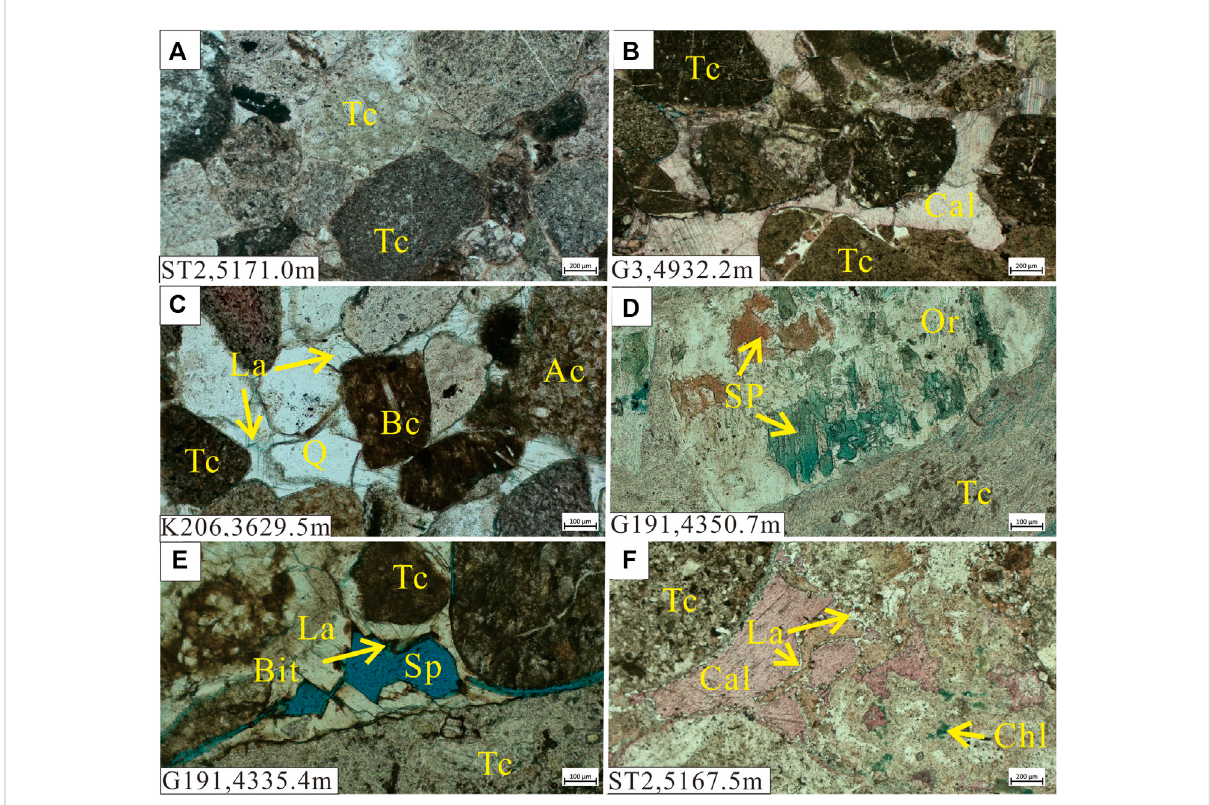
FIGURE 2 Photomicrographs of the Upper Wuerhe Formation. (A) Grayish white sandstone from a dry layer under plane-polarized light (PPL). (B) Water- bearing brown sandy conglomerate under PPL. (C) Water-bearing gray sandy conglomerate under PPL. (D) Brown gravelly conglomerate from a heavy oil-bearing layer under PPL. (E) Gray sandy conglomerate from a heavy oil-bearing layer under PPL. (F) Gray conglomerate from alow-quality oil-bearing layer under PPL. Tc: tuffaceous clast, Cal: calcite, Q: quartz, La: laumontite, Ac: andesite clast, Bc: basalt clast, Or: orthoclase, SP: secondary pores, Bit: bitumen, Chl: